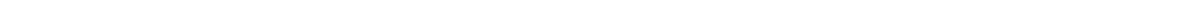
Fig. 3 CAF-S1-enriched HGSOC accumulate FOXP3 + T lymphocytes. a Representative views of HES staining of HGSOC tumor bed sections (Institut Curie cohort) showing lymphocytes accumulation at the surface of the stroma. Scale bar, 100 μ m (low magni fi cation) and 50 μ m (inset). b − d Scatter plots showing the number of CD3 + ( b ), CD8 + ( c ), and FOXP3 + ( d ) lymphocytes per mm 2 in epithelial and stromal compartments in HGSOC. N = 80 HGSOC (Institut Curie). P values are from Wilcoxon signed-rank test. e, g , i Representative views of CD3 + ( e ), CD8 + ( g ), and FOXP3 + ( i ) immunostaining in HGSOC enriched in CAF-S4 or CAF-S1. Scale bar, 50 μ m. f , h , i Number of immune cells per mm 2 in CAF-S1- and CAF-S4-enriched HGSOC, considering either the whole sections referred to as Total or the epithelial and stromal compartments. Positive cells for each staining were counted manually in at least 5 − 10 fi elds per tumor at ×20 magni fi cation. The median is indicated. Mann-Whitney statistical test was performed to compare CAF-S1- versus CAF-S4- enriched tumors and Wilcoxon paired test was used to compare epithelial and stromal compartments within tumors. N = 80 HGSOC (Institut Curie). k , l Scatter plots showing the number of CD3 + ( k ) and FOXP3 + ( j ) T lymphocytes per mm 2 relative to the stromal or epithelial content per tumor, in CAF-S1- or CAF-S4 enriched HGSOC. P values are from Mann-Whitney test. m Representative views of CAF maps, with the corresponding heatmap showing the localization of CD3 + T lymphocytes (0.25 mm 2 ). The bar plot shows the number of CD3 + T lymphocytes detected at the surface of epithelial cells (Epith) or of each CAF subset cell ( n = 936 total cells per image, fi ve images from different HGSOC were analyzed). P values are from Student ’ s t